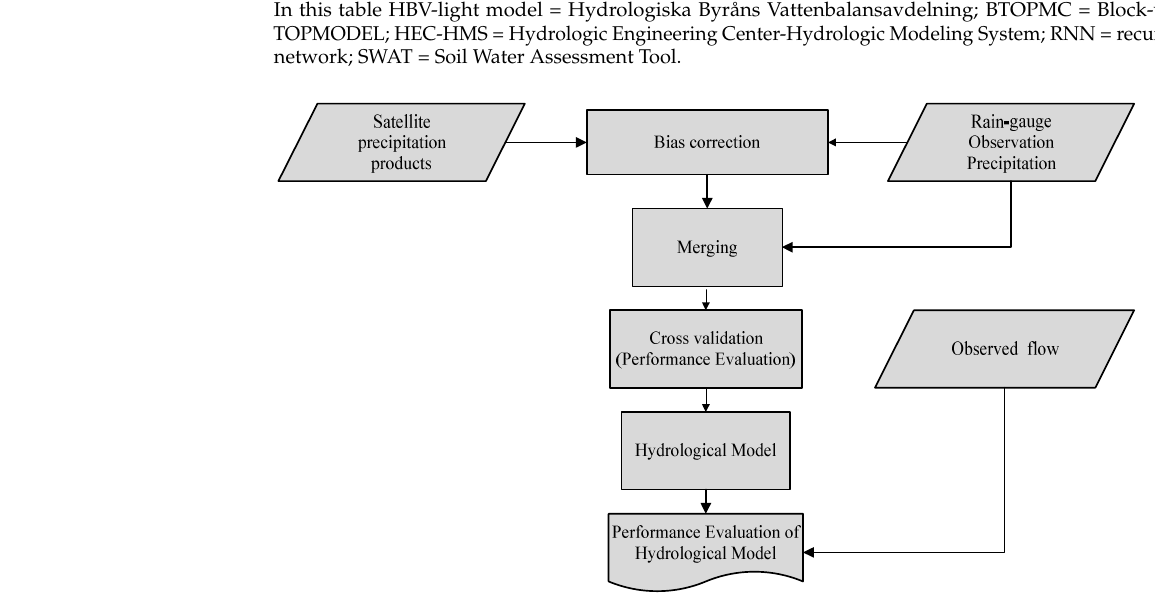
Figure 1. General framework for the application of merged precipitation products for hydrological simulation.